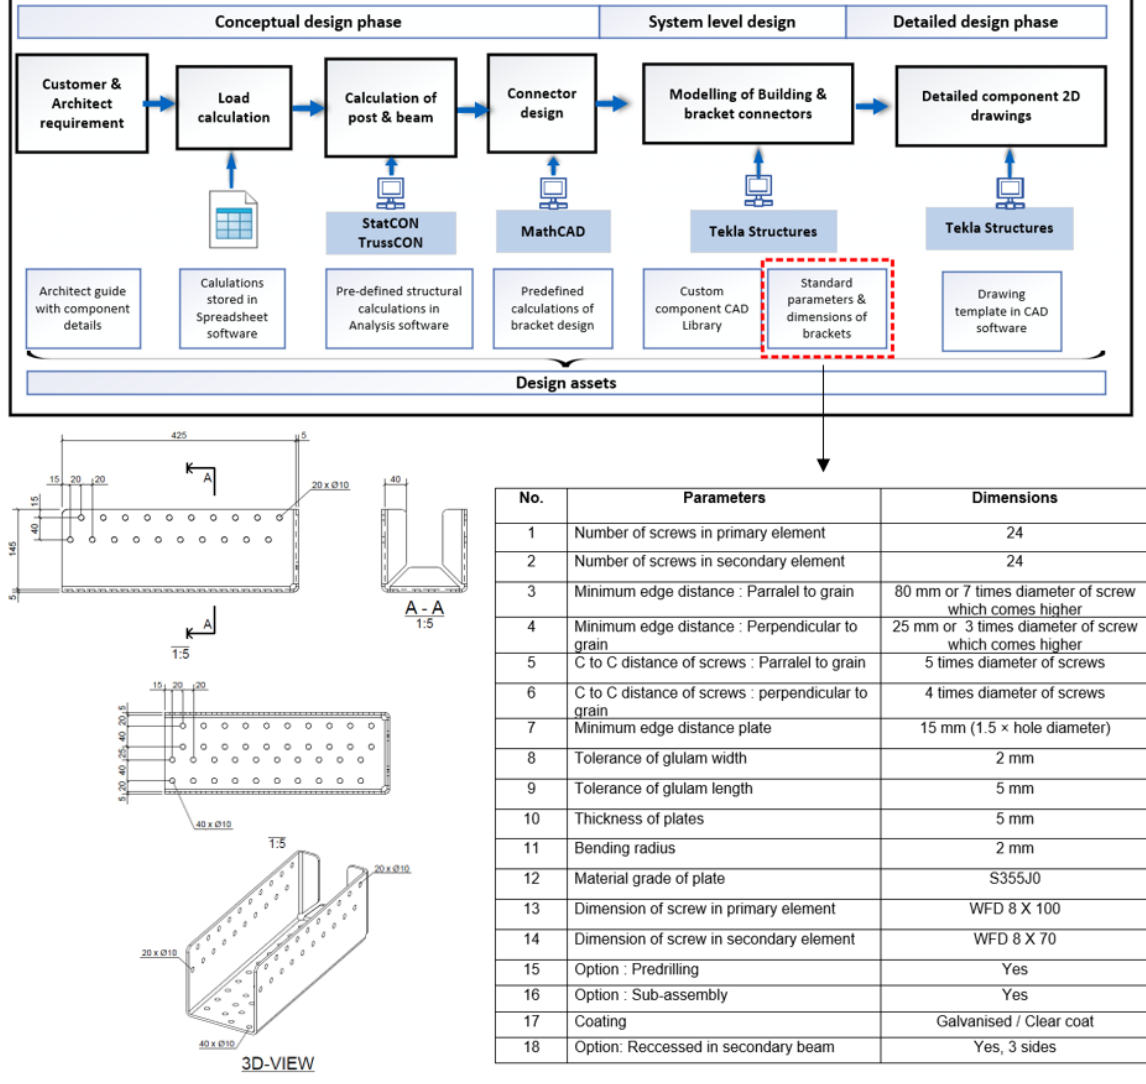
Figure 4. Potential assets and standard parameters in the bracket design.